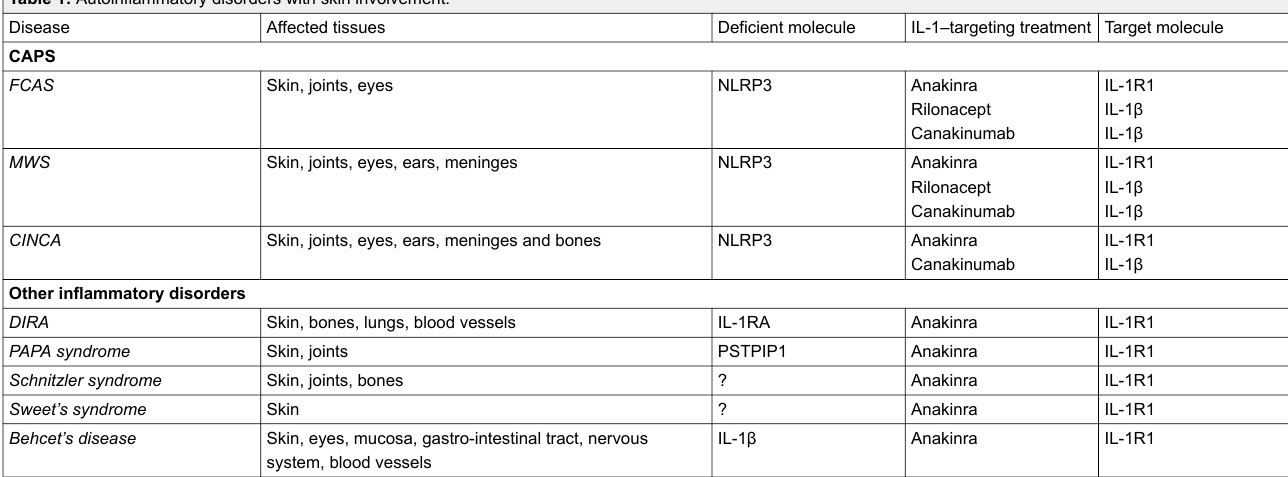
Table 1: Autoinflammatory disorders with skin involvement.